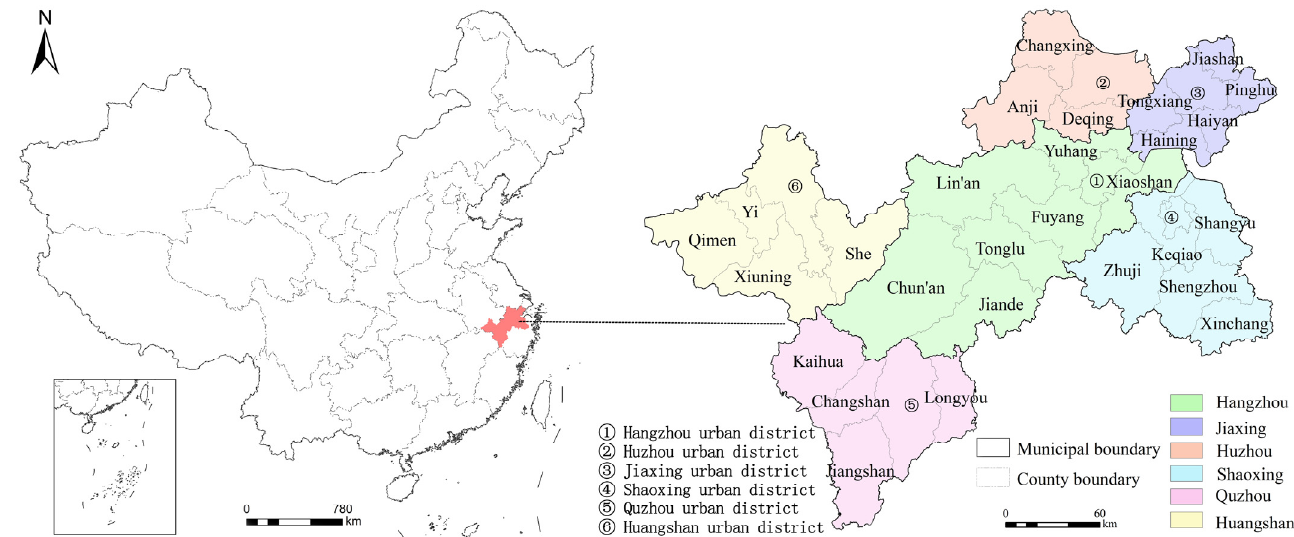
Figure 1. Location of Hangzhou metropolitan circle in China.